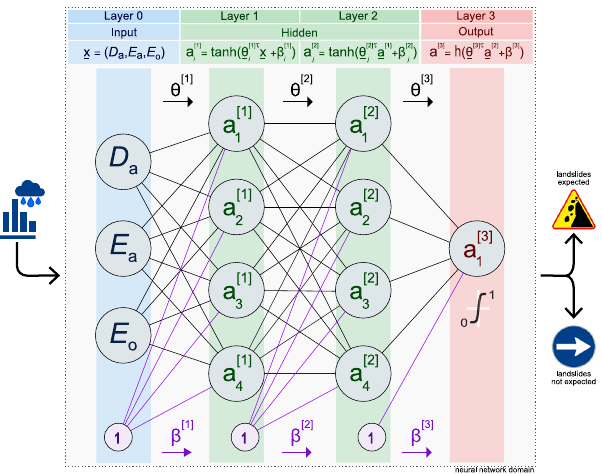
Fig. 3 | Neural network geometry for every model M i . Grey circles are neurons arranged in four layers. Blue, input layer 0; green, hidden layers 1 & 2; red, output layer 3. Neurons in the hidden (green) layers are activated by a tanh function. Output(red)layerisactivatedbyasigmoidfunctionh.a k n isneuron n inthe k layer, β [ k ] is the biasadded to the n neuron in the k layer, and θ k θ [ k ] isthe weight β ½ k (cid:2) n in n in array of the neurons in the k − 1 layer in the n neuron of the k layer. τ stands for transpose.